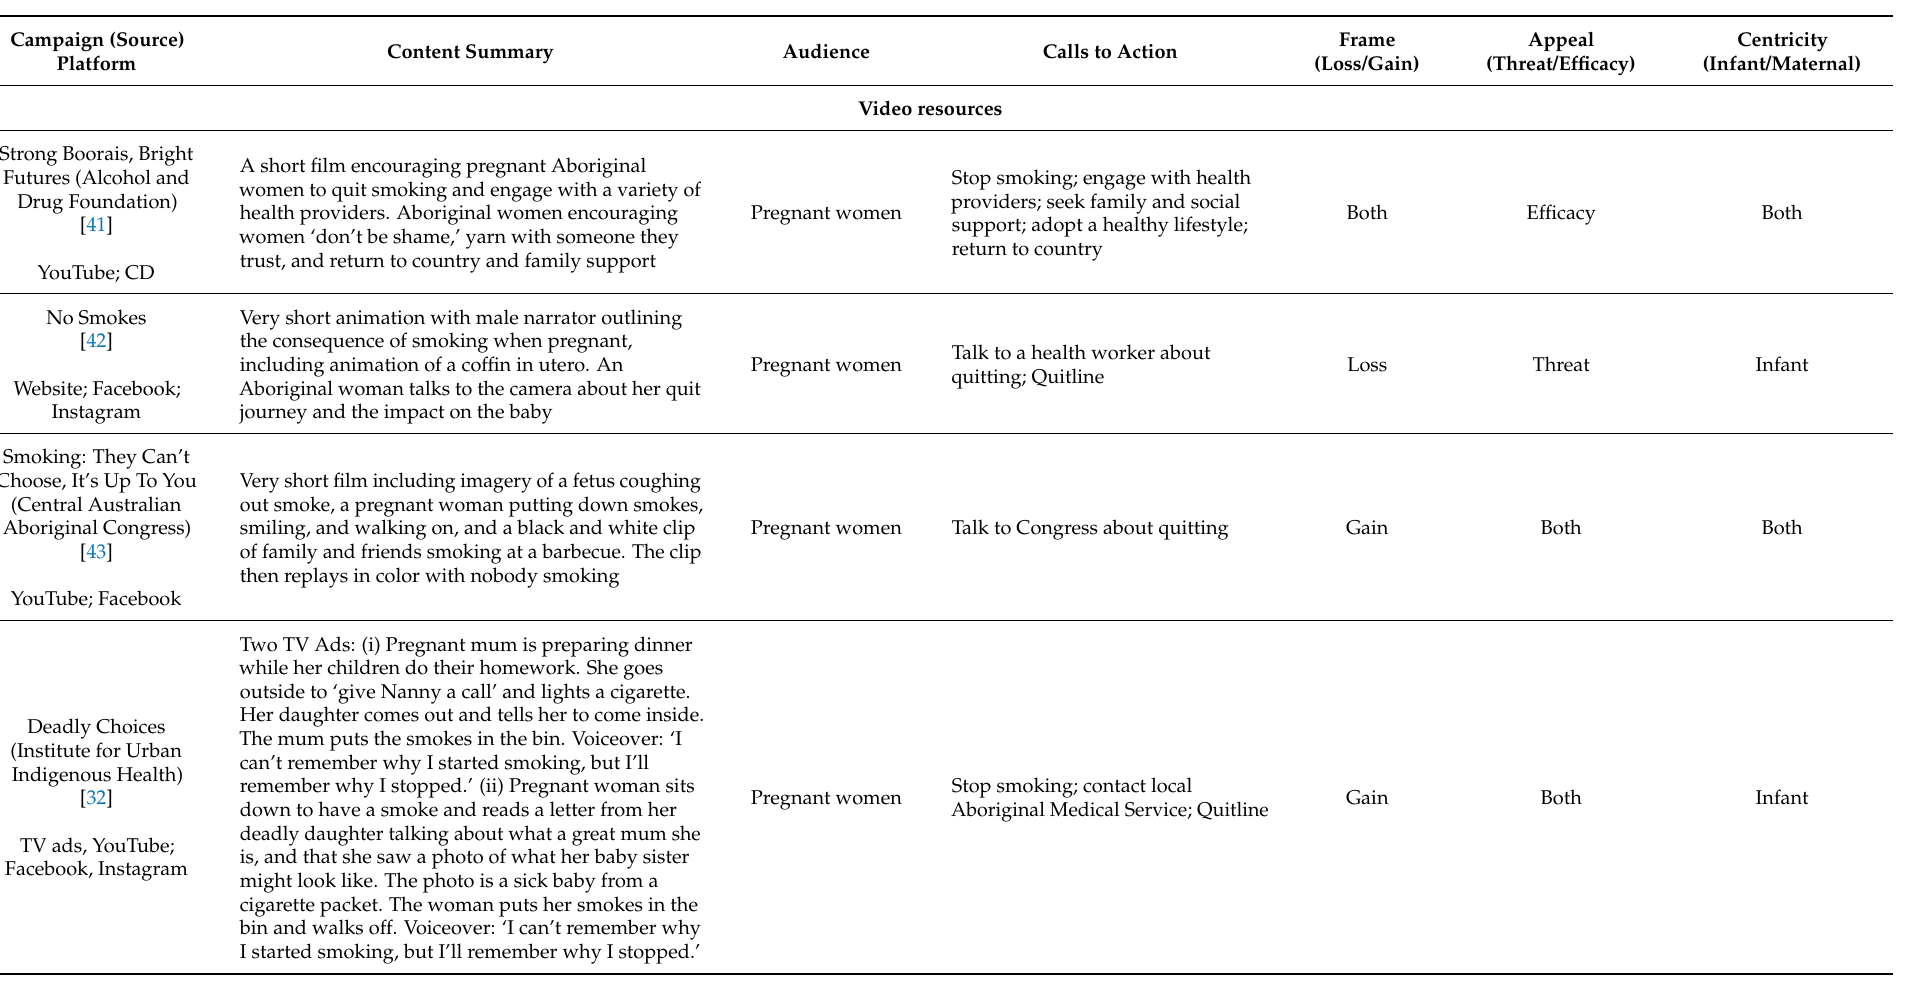
Table 3. Summary of health promotion